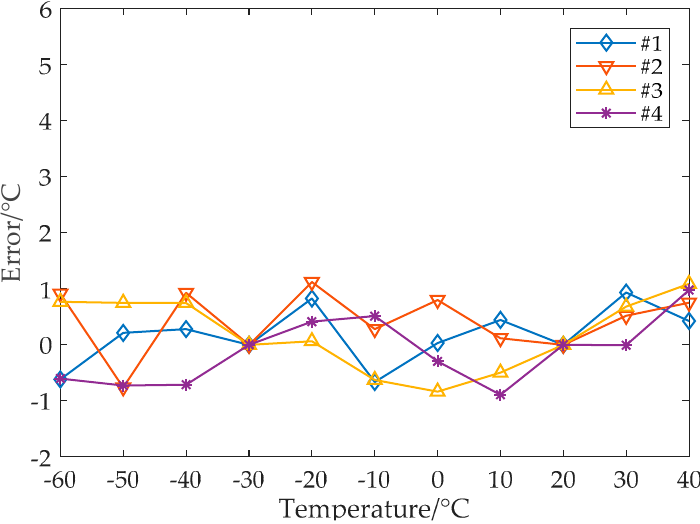
Figure 11. Temperature measurement error for the range of − 60 to + 40 ◦ C with the proposed nonlinear calibration.